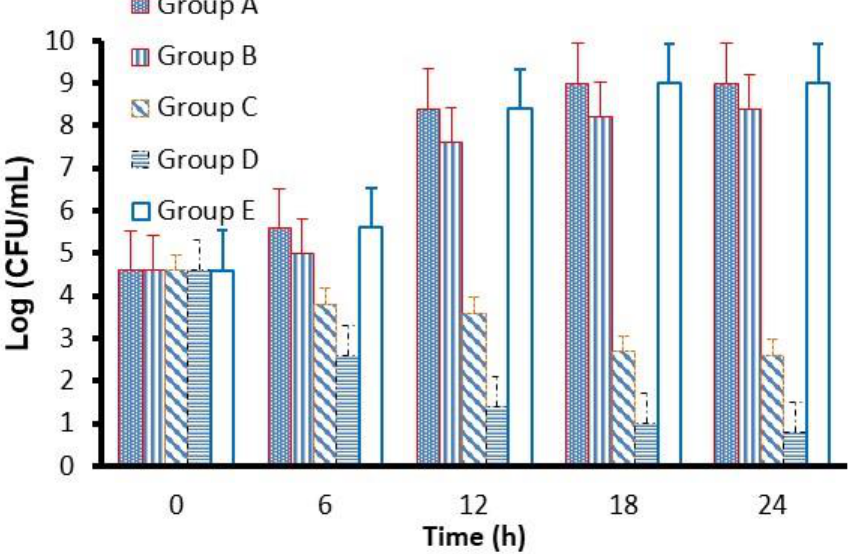
Figure 4. CFU of S. mutans cultivated with different samples: (A) Group A BIOD; (B) Group B — 0.5% ROE-AgNPs with 99.5% BIOD; Group (C) C — 99% BIOD with 1% Cefuroxime-ROE-AgNPs nanontibiotic (1:1); Group (D) D — 98% BIOD with 2% Cefuroxime-ROE-AgNPs nanontibiotic (1:3); Group (E) E — 98.5%BIOD with 1.5% cefuroxime.